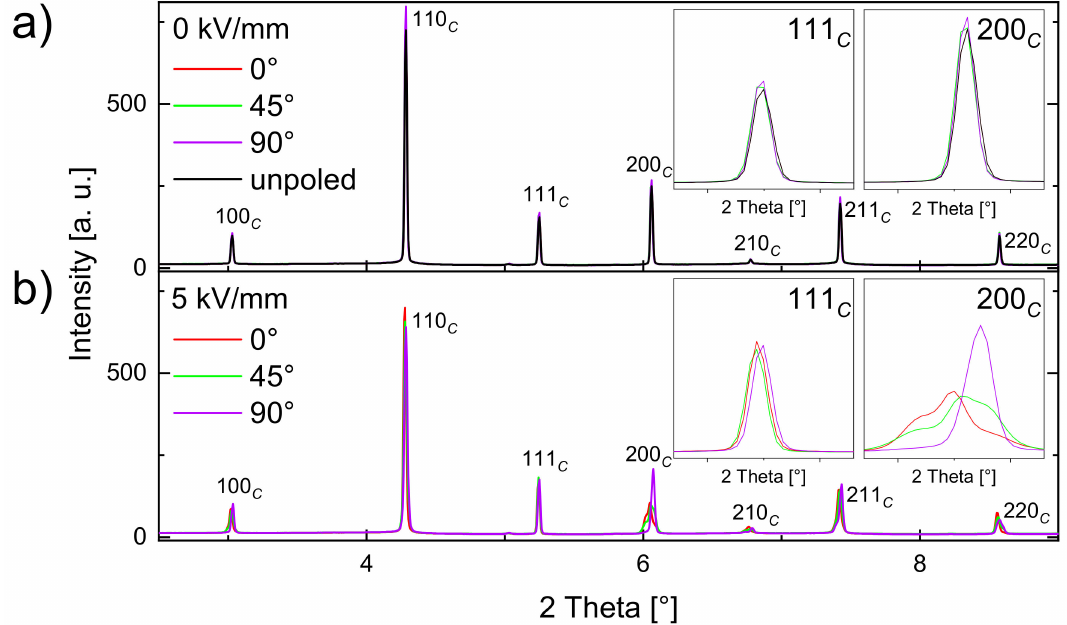
Figure 3. Orientation-dependent di ff raction patterns of BNT–12BT in the remanent state ( a , red, green, and blue line) and one orientation of the unpoled virgin state ( a , black line). Since the patterns are almost identical, the colored lines mostly lie on top of each other. Maximum electric field at 5 kV / mm ( b ) during one bipolar cycle at a frequency of 1.9–10 − 4 Hz. Three di ff erent azimuthal angles ϕ = 0 ◦ , 45 ◦ , and 90 ◦ are shown, which represent scattering vectors that lie parallel, 45 ◦ , and perpendicular to the electric field vector, respectively. The insets show the 111 C and 200 C reflections, which are considered to indicate tetragonal or rhombohedral unit cell distortions and domain